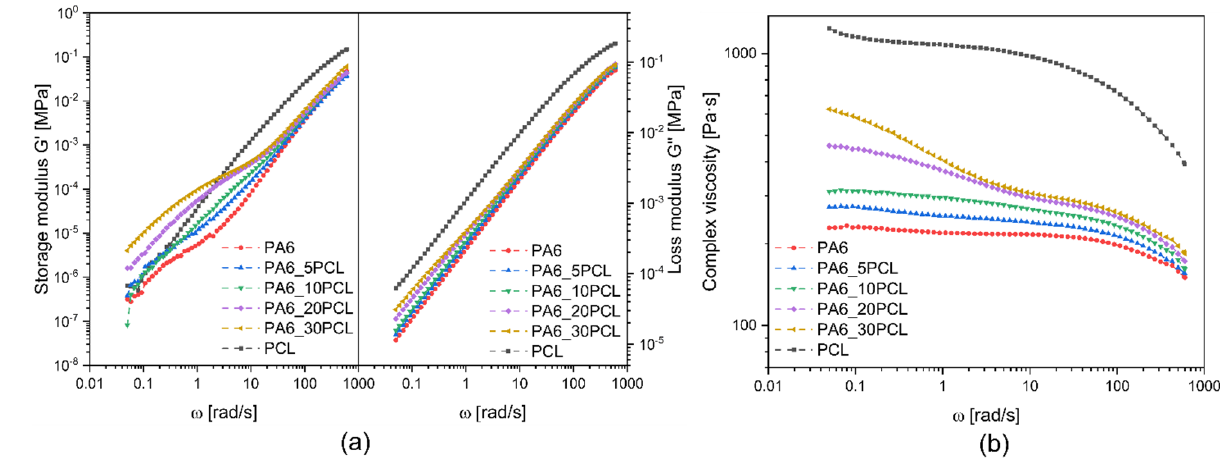
Figure 2. Dynamic rheological behavior of the produced PA6/PCL blends. Trends of ( a ) storage and loss modulus and of ( b ) complex viscosity as a function of the angular frequency.